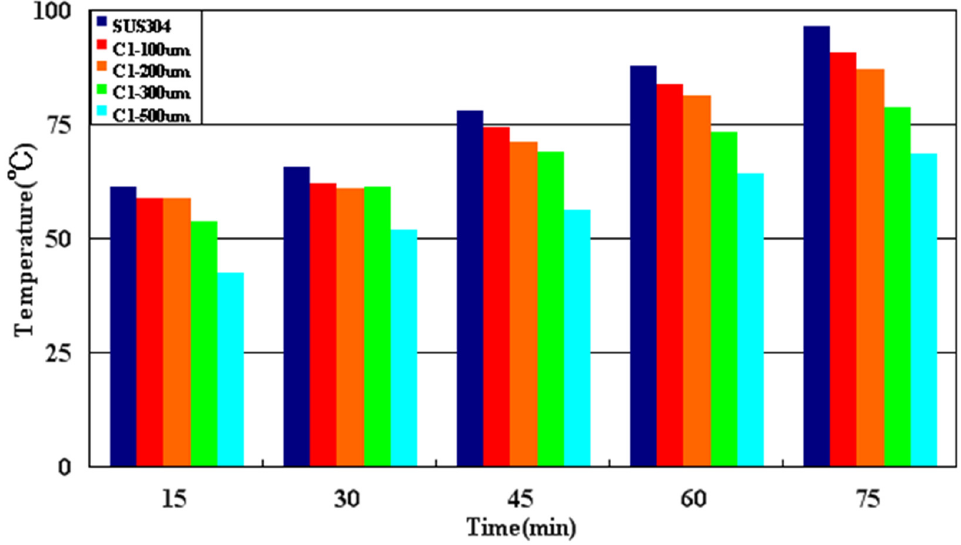
Figure 10. The temperature change analysis of C1. Table 6. The temperature difference between the surface of SUS304 and coating surface of C. Time (min)